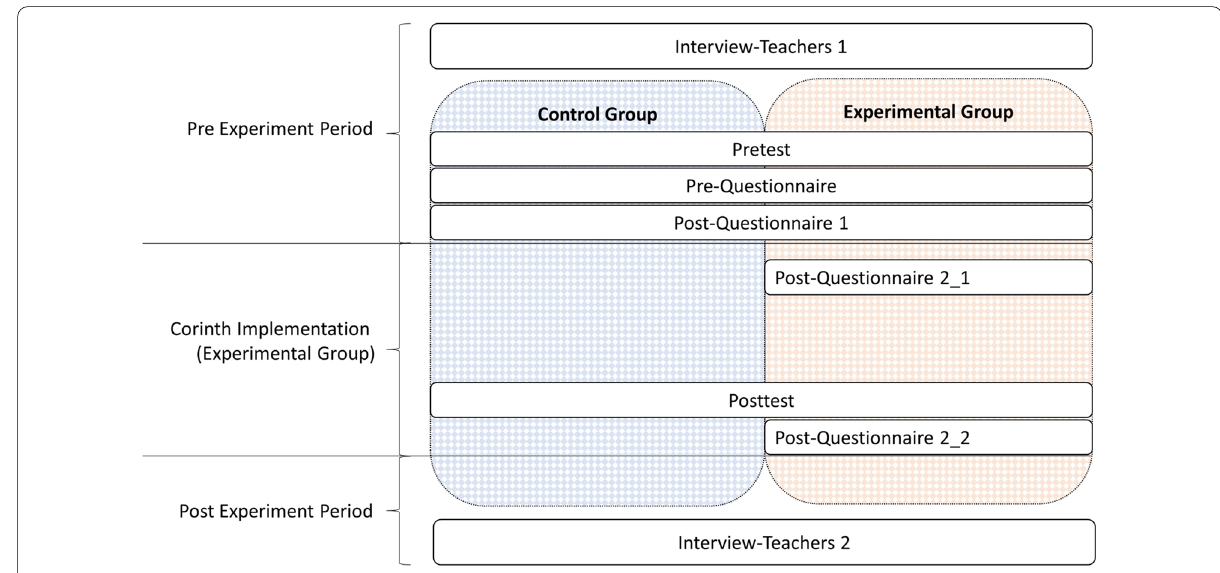
Fig. 2 Diagram showing the timeline of the implementation of each research